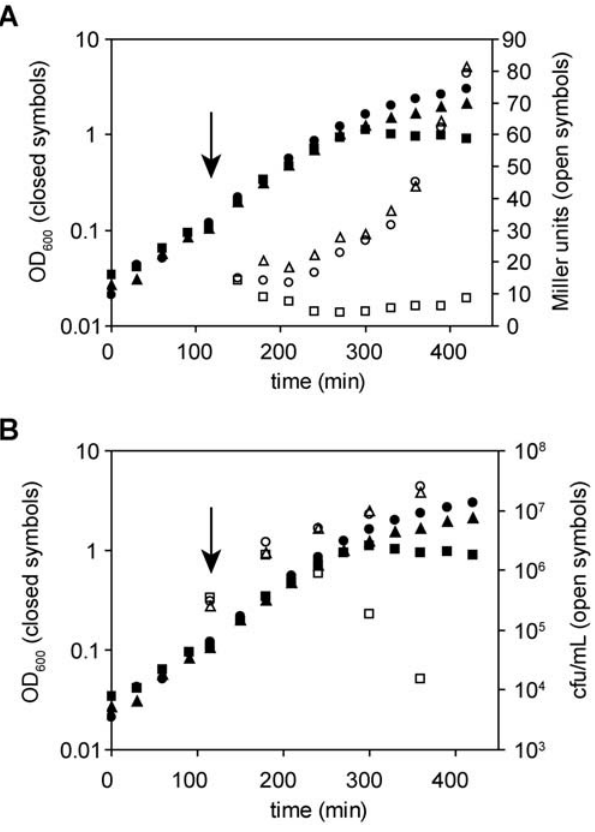
Figure 2. Inhibition of s E activity caused cell death. Strains SEA007 (squares, pRseAB), SEA008 (circles, pTrc99a vector control), and SEA4044 (triangles, pRseAD11H) were grown in LB at 30 u C with shaking in a gyrotary waterbath. IPTG was added at OD 600 , 0.1 to induce overexpression of rseA and rseB , indicated by the arrow. (A) s E was inhibited by overexpression of rseA and rseB , but not rseA D11H and rseB , as shown by b -galactosidase activity measured from the s E - dependent rpoH P3- lacZ reporter. Miller units (open symbols, right axis) and OD 600 (closed symbols, left axis) are plotted at each time point. (B) Overexpression of rseA and rseB , but not rseA D11H and rseB , caused a reduction in the colony forming units and optical density. OD 600 (closed symbols, left axis) and cfu/ml (open symbols, right axis) were measured throughout the growth curve. A representative experiment is shown in both panels.